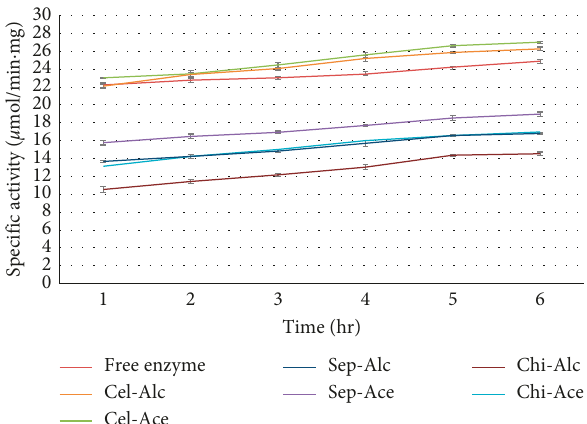
Figure 6: Timeline of hydrolysis reaction at [S] and temperature 45 °